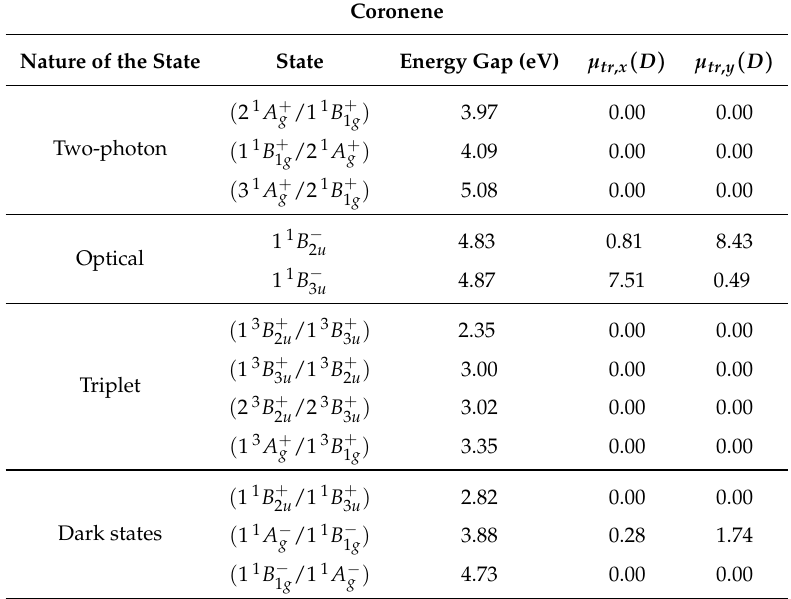
Table 2. Energies of low-lying two-photon states, optical states, triplet states, and a few other optically-dark states in coronene, relative to the ground state. Although coronene has D 6 h symmetry, here, the states are labeled by the symmetry representations of its subgroup D 2 h . Whenever a state cannot be uniquely labeled due to lower symmetry employed in the study, both possible labels for the state have been given. The transition dipole moment (in Debye) from the ground state to the excited states ( µ tr , x / y ) along specific axes is also specified in the last two columns. Energies determined by UV-visible spectroscopy are also mentioned in Footnotes (a) and (c). Coronene Nature of the State State